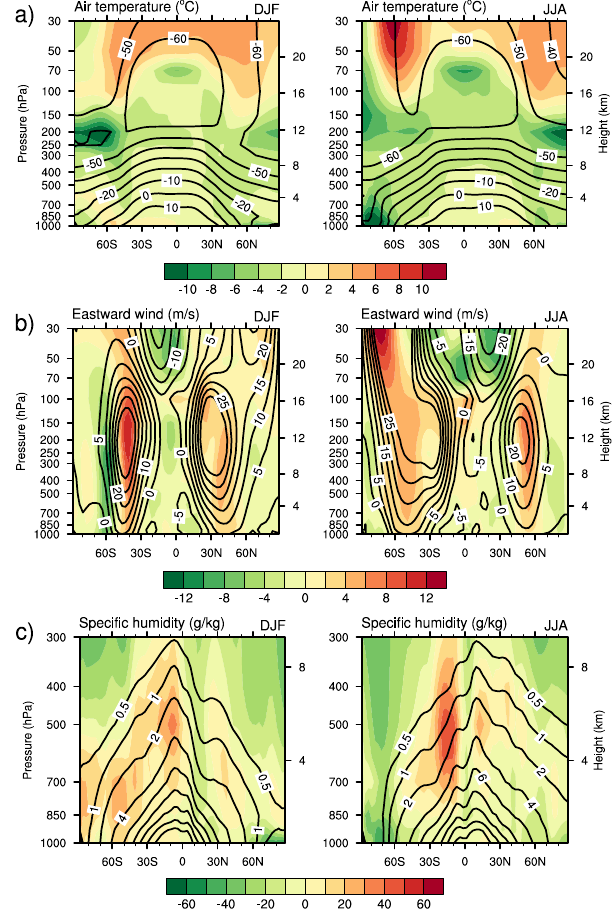
Figure 3. Zonally averaged air temperature (a) , zonal wind (b) and specific humidity (c) climatology from BNU-ESM historical sim- ulation (black contours) and bias relative to the ERA-Interim cli- matology (color filled, color bar is of same units except as % for specific humidity) for